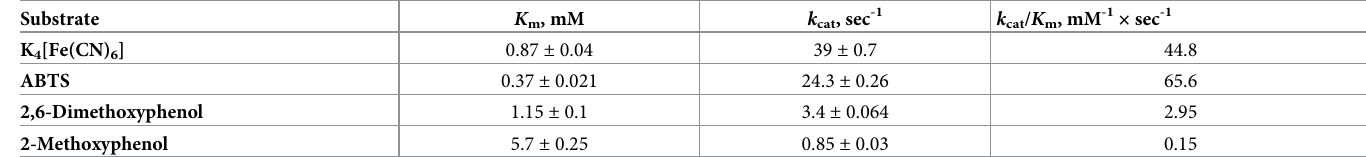
Table 1. Kinetic parameters for the oxidation of phenolic and nonphenolic substrates by two-domain laccase of S . puniceus .